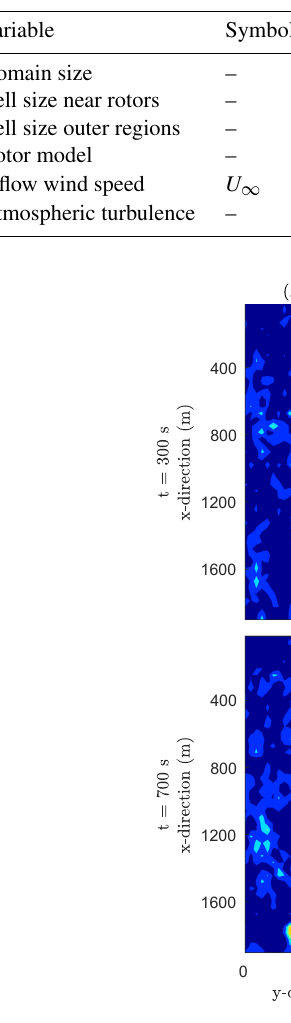
Figure 4. Comparison of absolute values of the estimation errors (in long. flow fields) for state-only estimation with the ExKF, EnKF and UKF at t = 300s and t = 700s, with ( (cid:49) u ) (cid:113) = | u (cid:113) − u SOWFA | . The model and KF settings are depicted in Tables 1, 2, and 3. Wind is coming in from the top, flowing towards the bottom. The measured states are depicted by red dots in the flow, not to be confused with estimation error. The KFs consistently improve the instantaneous flow field estimations, noticeably nearby the